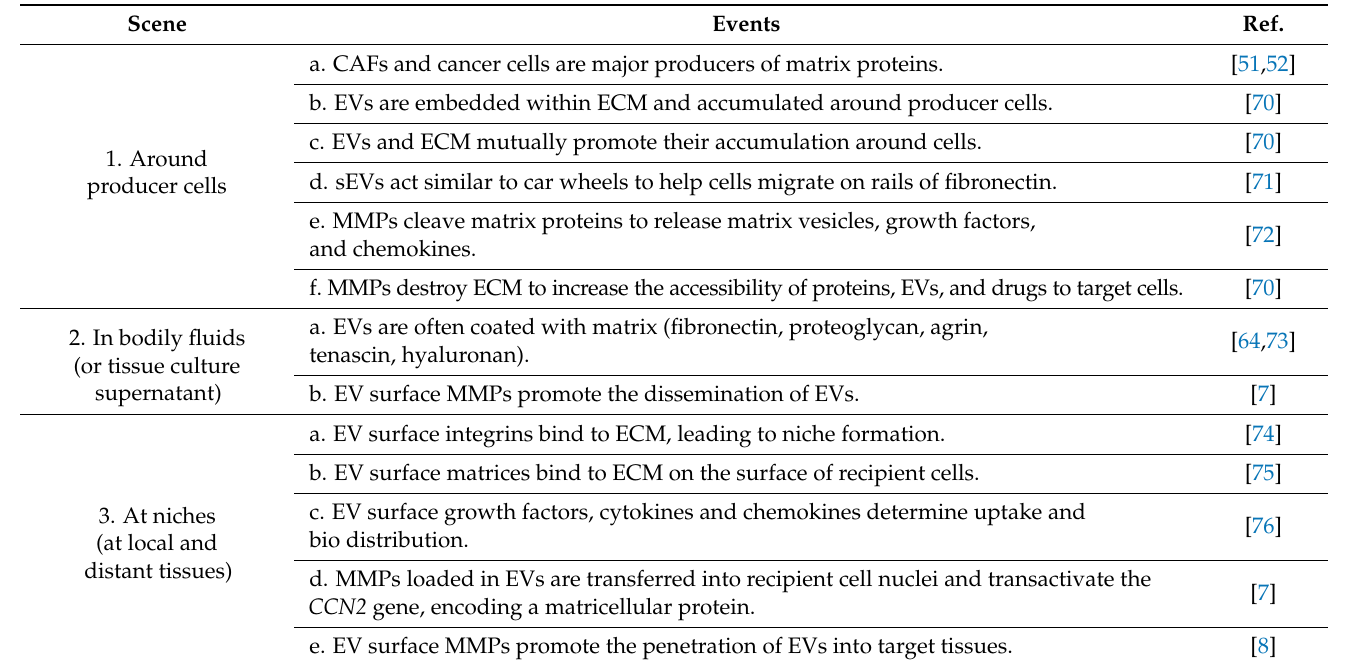
Table 2. Extracellular matrix–vesicle